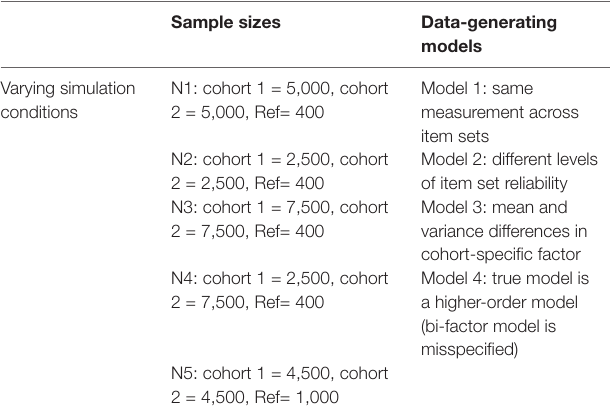
TABle 1 | Various data-generating models and sample sizes used in simulations, resulting in 20 simulation conditions. Sample